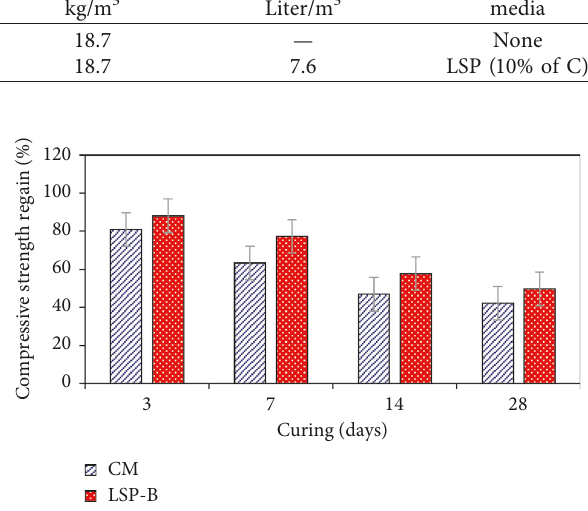
Figure 6: Percentage regain in compressive strength of mortar formulations with and without immobilized microbes at different precracked